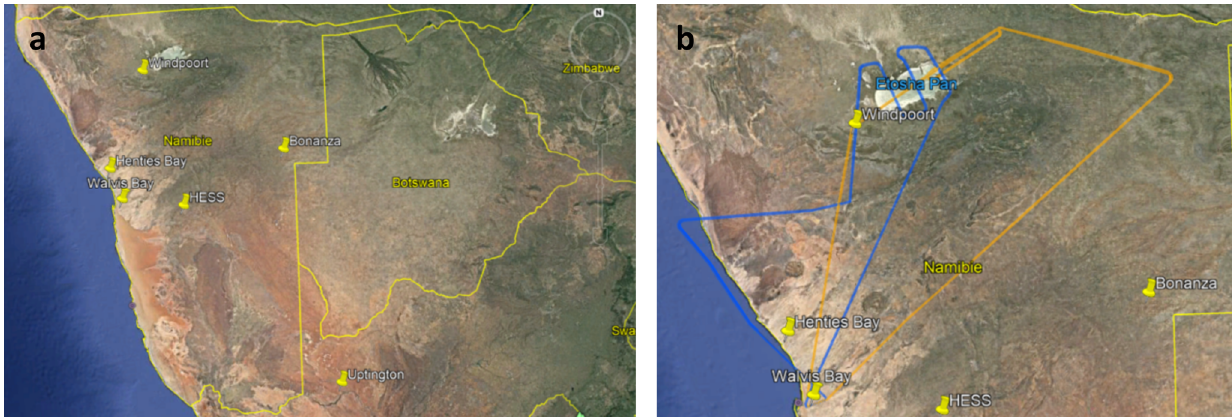
Figure 1. (a) Geographical map of Namibia and surrounding countries with the location of the main sites of interest: Walvis Bay (airport), Henties Bay (AEROCLO-sA main ground-based supersite), and AERONET stations in Windpoort, HESS, Bonanza (Namibia), and Upington (South Africa). (b) Zoom on northern Namibia, where the Etosha pan is located (white area just northeast of Windpoort). The blue solid line represents the SAFIRE Falcon 20 flight track on 5 September in the morning (07:36–10:14UTC), and the orange solid line represents the Falcon 20 flight track on 6 September in the afternoon (10:55–14:01UTC). Map credit: © Google Earth